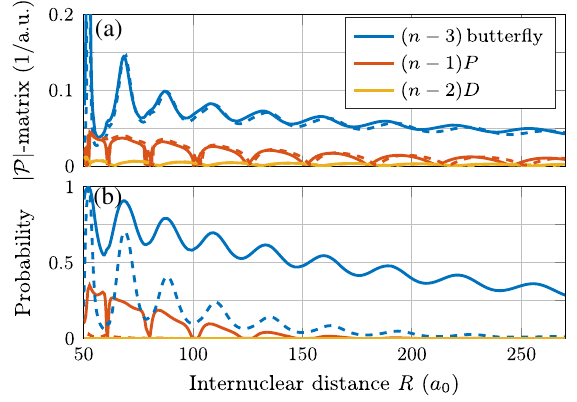
FIG. 13. (a) P -matrix elements associated with the butterfly- trilobite coupling (blue), ð n − 1 Þ P -trilobite (red), and ð n − 2 Þ D - trilobite crossing (orange) for two different principal quantum numbers, n ¼ 40 (dashed lines) and n ¼ 90 (solid lines). (b) Probability for nonadiabatic transitions associated with the P matrix displayed in panel (a) (see text for